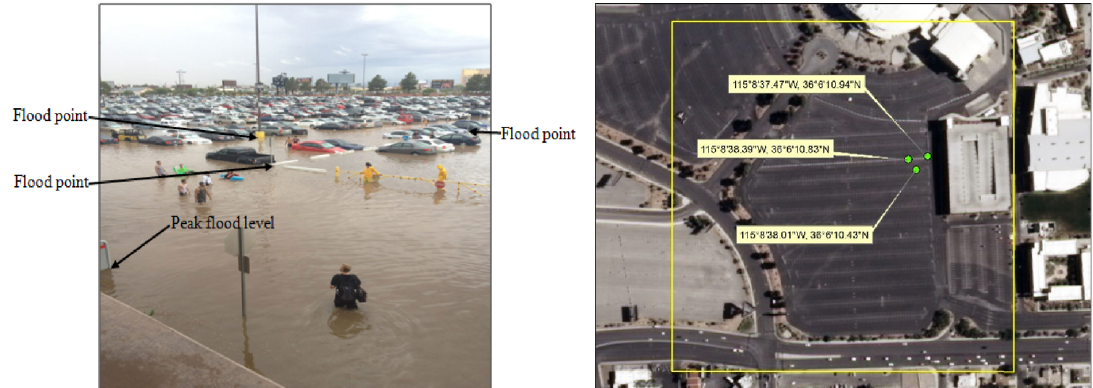
Figure 10. Imagery used for model calibration showing the location of some of the known flood points and the peak flood depth location at the inlet where watermark was still intact after flooding ( on the left ) verified through a field visit, and the exact geographic location of the points recorded via field visit with a GPS ( on the right ). Courtesy of Rebel Yell, University of Nevada Las Vegas.